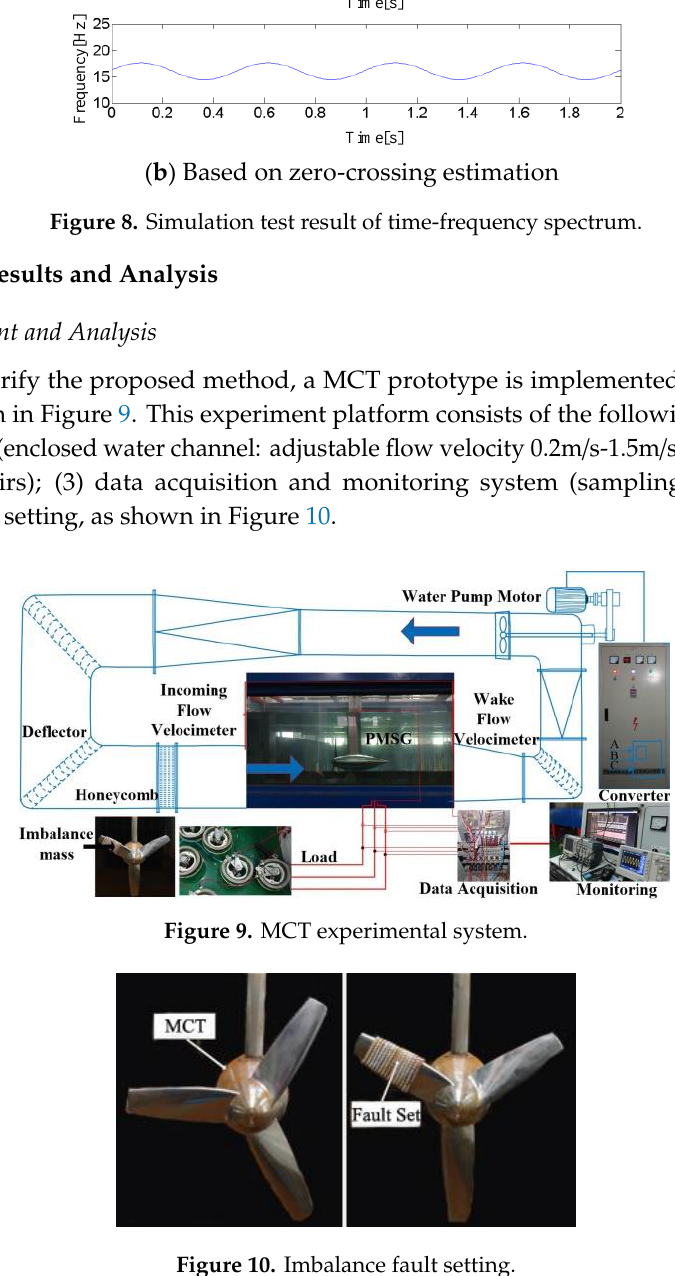
Figure 10. Imbalance fault setting.